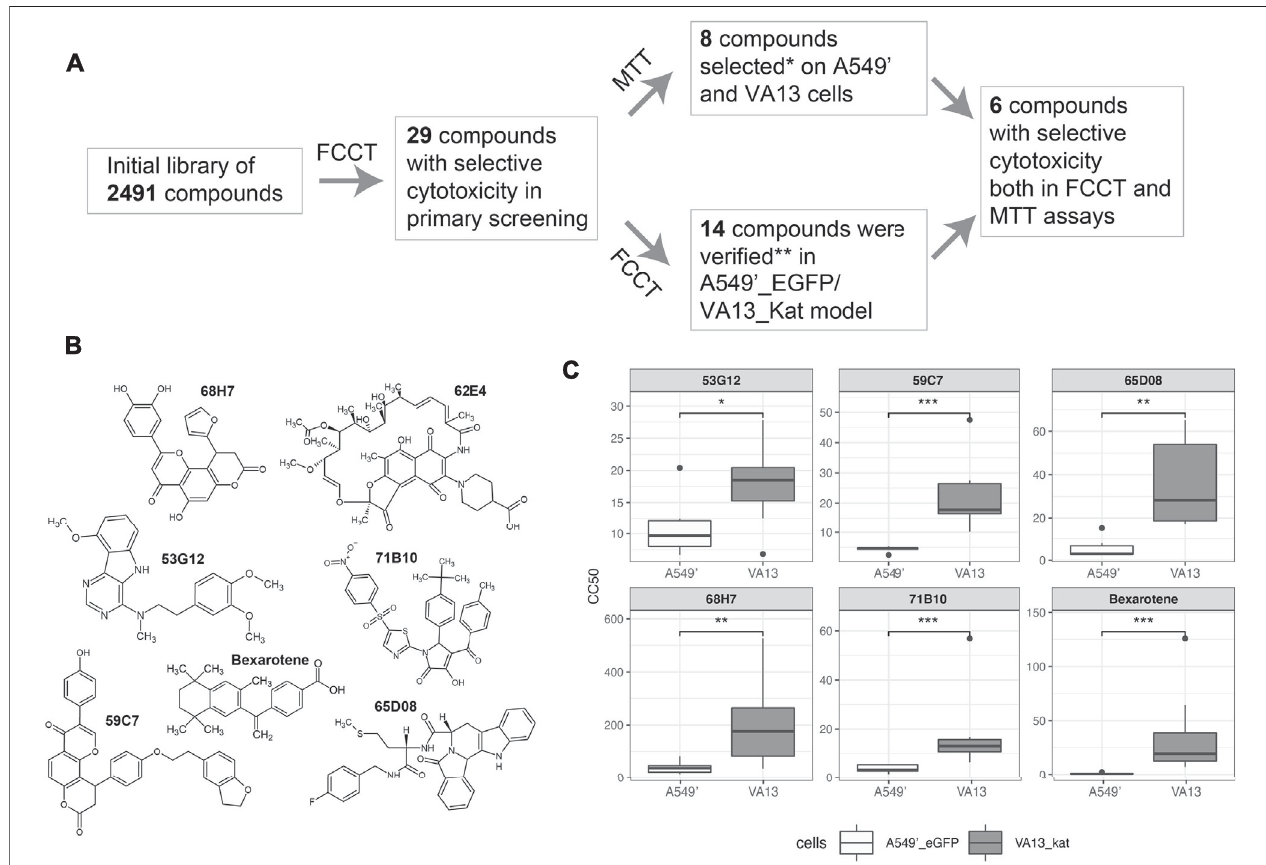
FIGURE 3 | Scheme of the selection of active compounds and their structures. (A) . The screening and validation of the selectively cytotoxic compounds. (B) . Structures of compounds 59C7, 62E4, 68H7, 71B10, 65D8, and 53G12, that were selectively cytotoxic in both MTT and FCCT tests. *27 compounds from the initial library lot were analyzed in MTT. **28 compounds from a new lot were tested with the FCCT assay. (C) . CC50 values of hit compounds were measured in the eight- replicated FCCT test and compared by the Wilcoxon test. Asterisks indicate the range of p -values: 0.05 ≤ p < 0.1 (*); 0.01 ≤ p < 0.05 (**); p < 0.01 (***); not signi fi cant